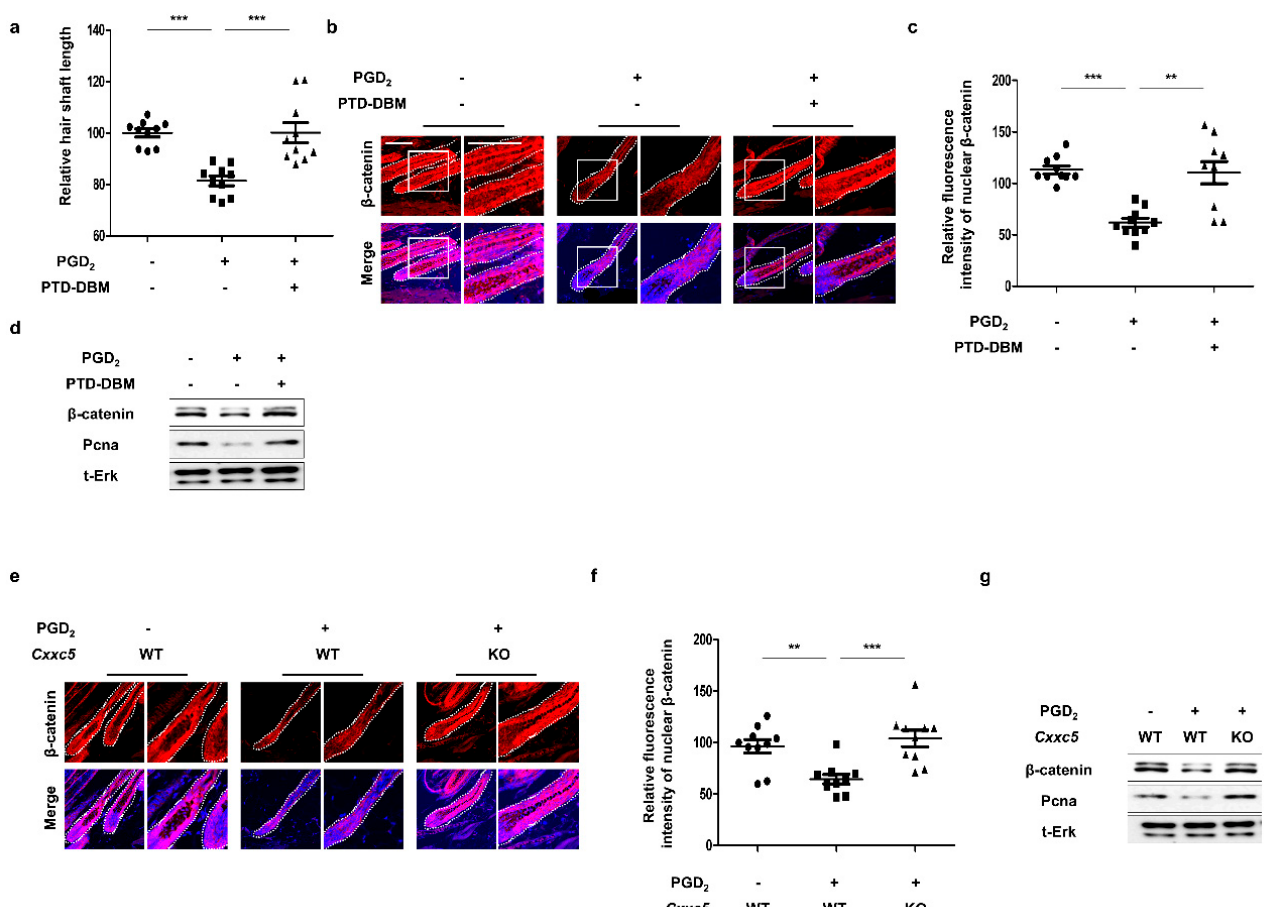
Figure 3. Effects of blockade of Cxxc5 function on hair regrowth. ( a – d ) The dorsal skins of C57BL/6N 7-week-old wild-type mice were depilated and harvested at 12 or 20 days. Topical treatment with 10 µ g PGD 2 or 10 mM PTD-DBM every other day was performed from 8 days to 12 or 20 days. ( a ) The relative hair shaft length 20 days after depilation ( n = 10). ( b ) IHC staining for β -catenin at 12 days after depilation. ( c ) Quantitative calculations for fluorescence intensities of nuclear β -catenin ( n = 10). ( d ) Immunoblotting analyses for β -catenin, Pcna, and total Erk at 12 days. ( e – g ) The back skins of 7-week-old Cxxc5 wild-type or knock-out mice were depilated and obtained at 12 or 20 days. Treatment of 10 μ g PGD 2 was conducted from 8 days to 12 or 20 days every other day. ( e ) IHC analyses for β -catenin at 12 days. ( f ) Quantitative values for intensities of nuclear β -catenin ( n = 10). ( g ) Immunoblotting assay for β -catenin, total Erk, and Pcna at 12 days. Scale bars = 100 μ m. Dotted lines indicate hair follicles. Values are expressed as means ± SEM. Student’s t -tests: ** p < 0.005, *** p < 0.0005.